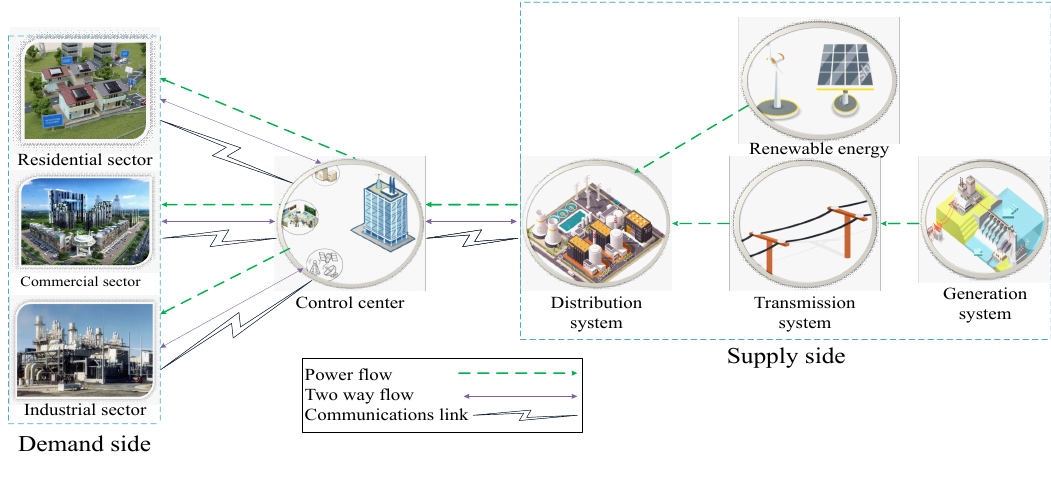
Figure 1. Abstract view